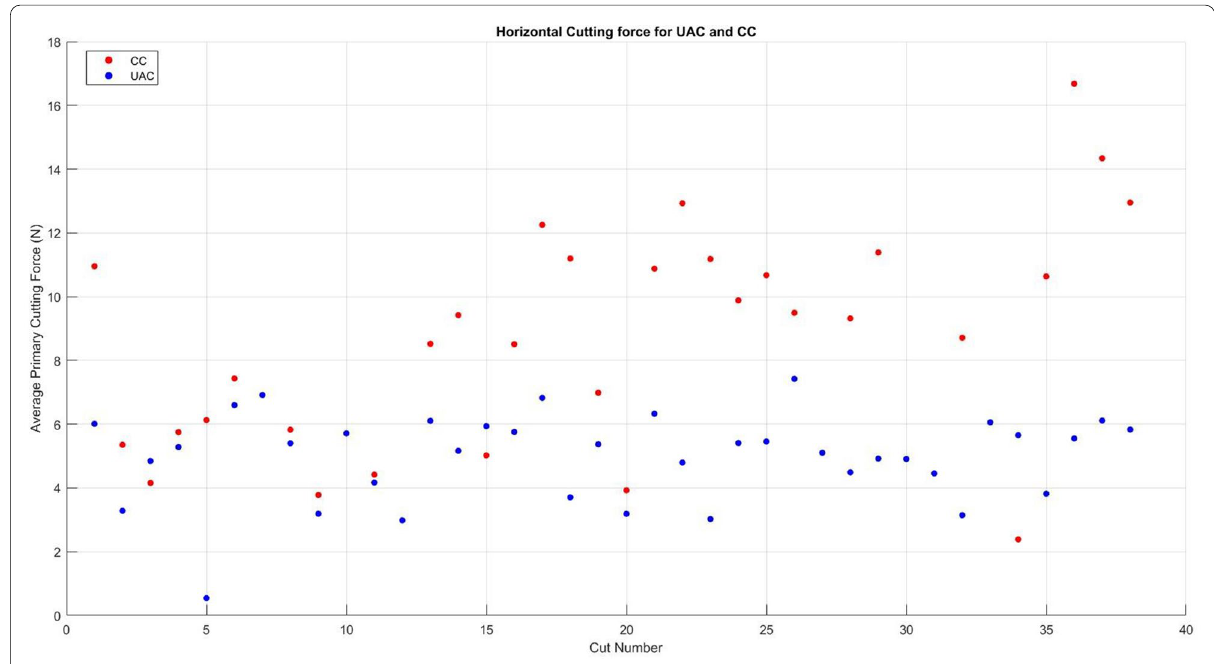
Figure 5 Plot showing magnitude of cutting force against the cut number for ultrasonically assisted (UAC) and conventional cutting (CC)